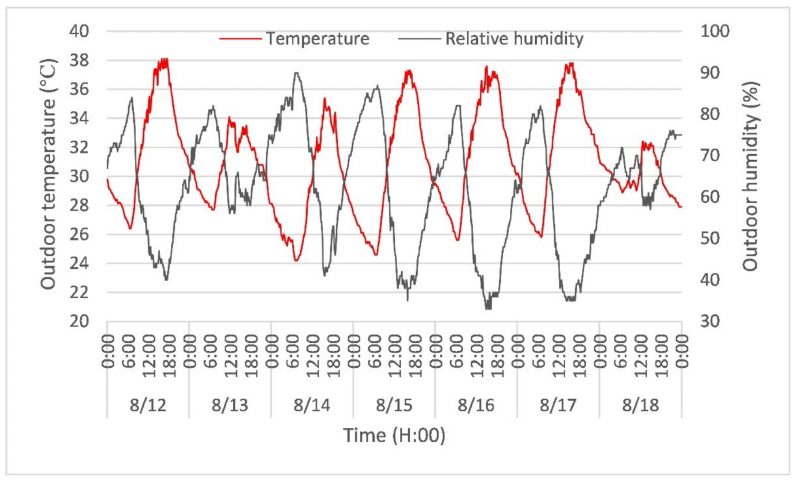
Figure 12. Outdoor temperature and relative humidity during the